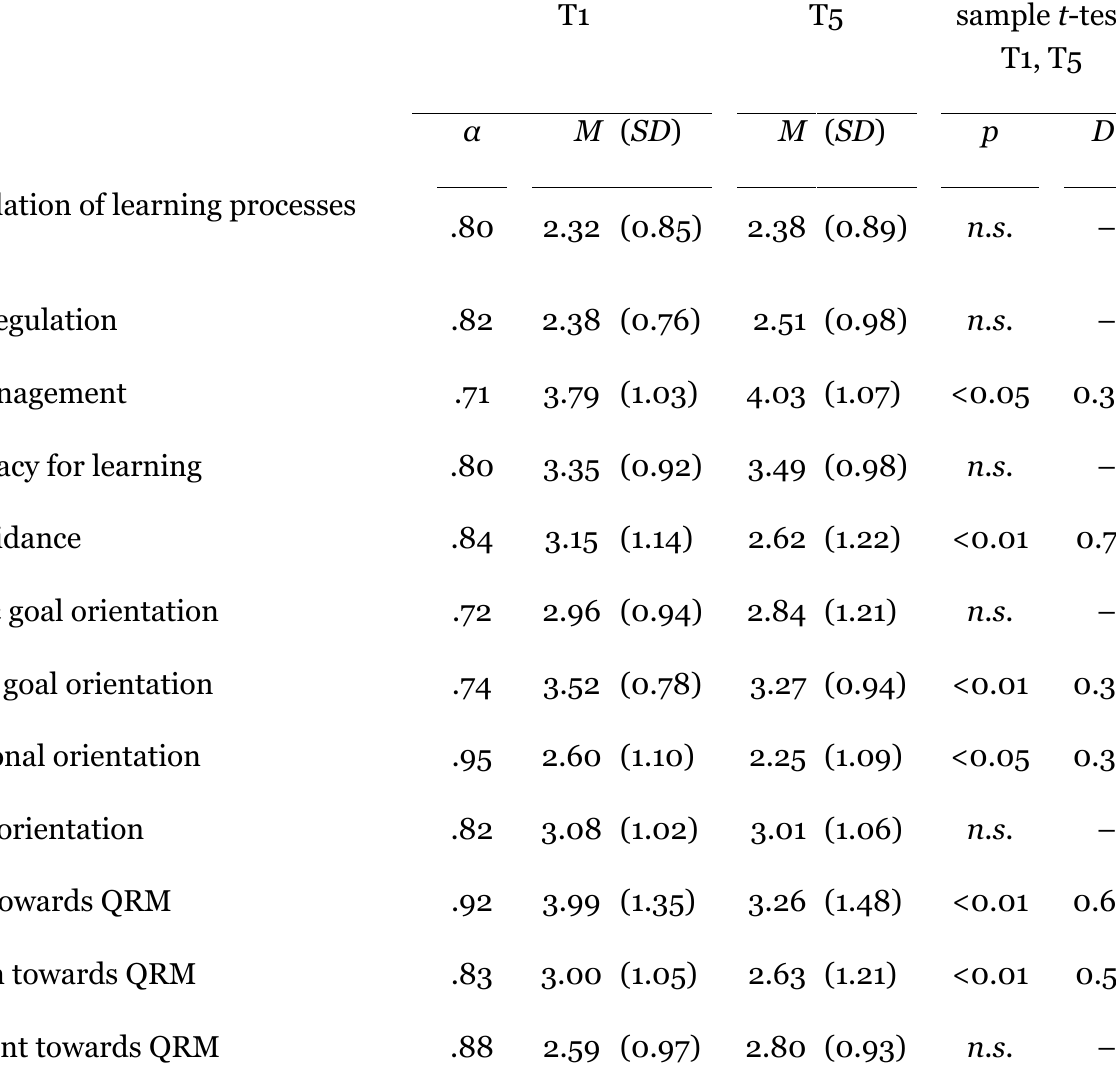
Reliability, descriptive statistics, and paired sample t-tests results of measured